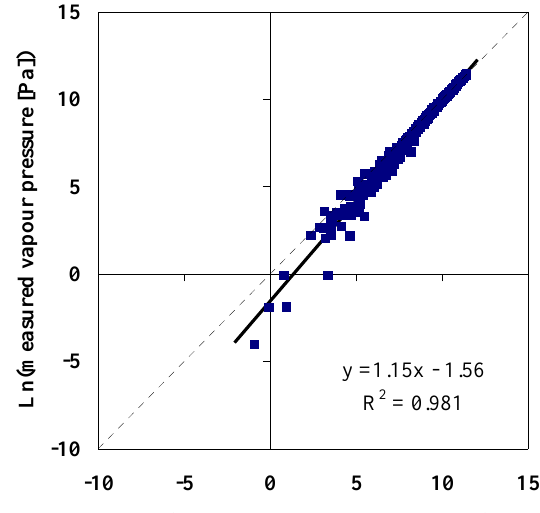
Figure 2. ln p predicted using the Ciacalone model for prediction of evaporation enthalpy. The line, which fits the data best, is of the general form: y = (1.15 ± 0.01) x - (1.56 ±